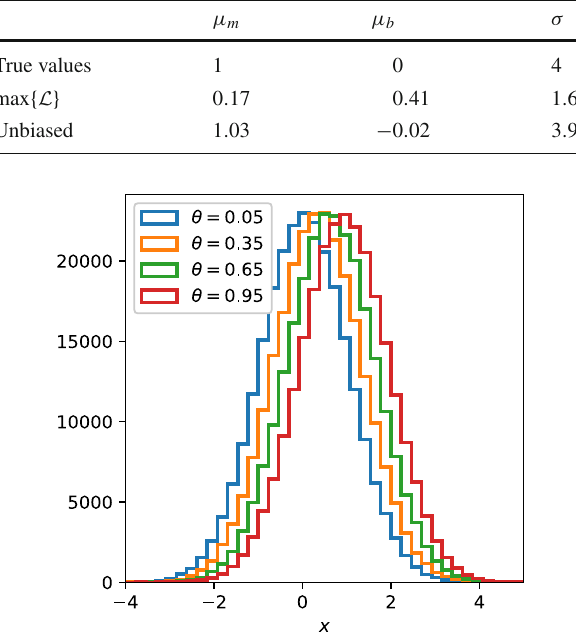
Table 1 The maximum likelihood estimators for the parameters of the function f , when determined using discrete parameter inputs, do not match the intended model parameters due to edge effects. Adding a constraint during likelihood optimization resolves this, and the results